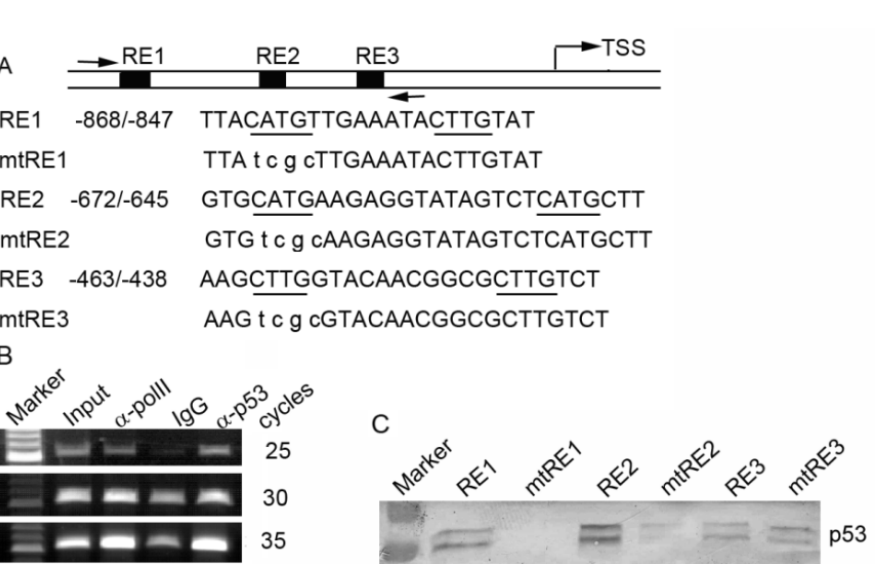
Figure 2. The p53 protein can bind to the promoter of the PA28 γ gene in vivo and in vitro